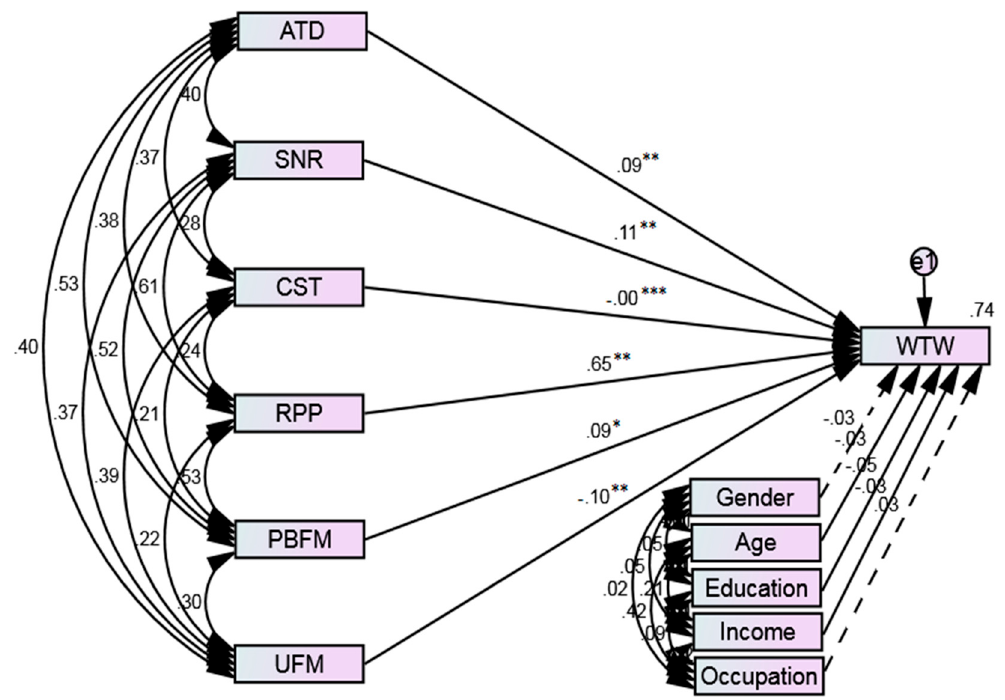
Figure 5. Path diagram of SEM. Solid lines represent significant paths, while dashed lines represent insignificant paths. *** p ≤ 0.001 (1%), ** p ≤ 0.01 (5%), * p ≤ 0.05 (10%).